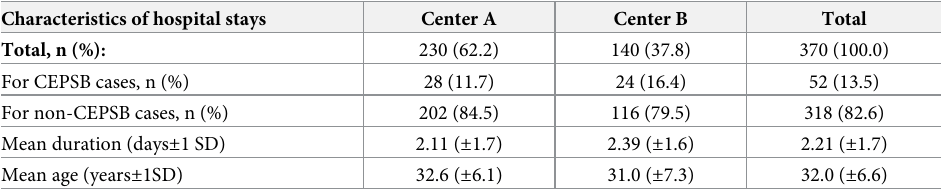
Table 2. Characteristics of hospital stays of patient aged between 18 and 45 years old hospitalized for acute pelvic pain or/and vaginal bleeding in two gynecological units in 2012 (N = 370). Characteristics of hospital